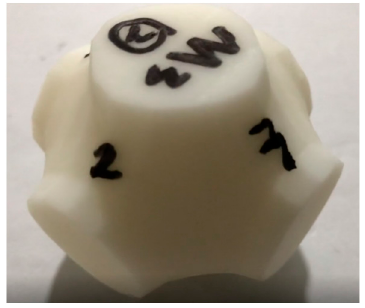
Figure 2. The SP unit cell bearing specimen manufactured by a 3D